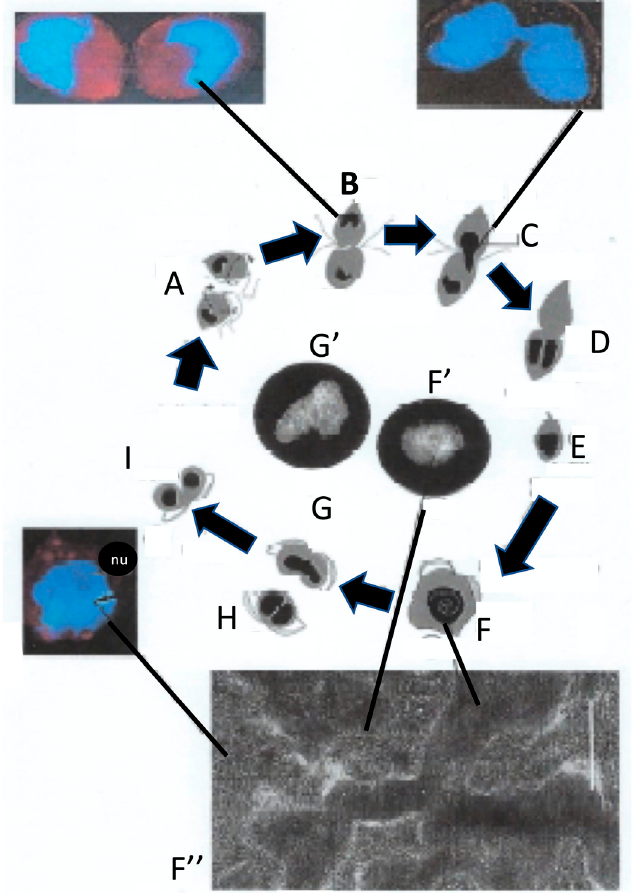
Figure 2. Course of sexual reproduction phases of the dinoflagellate Prorocentrum micans. (A)–(I): Haploid vegetative cells functioning as isogametes (A) become paired by means of their respective apical spines (B); then the donor cell injects its nucleus with stretched chromosomes into the receiver cell (C). (B), (C), (F), (F’): In vivo DAPI staining cells: (B) corresponds to B, (C) to (C), f to (F). After the two nuclei merge, (D) the zygote is diploid (E) and crossing over of the chromosomes can occur. Chromosomes become completely unwound and stretched. In the resultant diploid nucleus (F), chromatin begins to spin round (chromatic cyclosis) giving a rounded shape to the nucleus, as shown in the photograph (F). (F’): Detail of chromosome disorganised structure in a Transmission Electron Microscopic (TEM) view during the nuclear spin. Only one meiotic division occurred (G, G’, H), leading to 2q DNA-containing cells (I). Scale bar = 1 µ m. Reprinted/adapted with permission from Ref. [13].